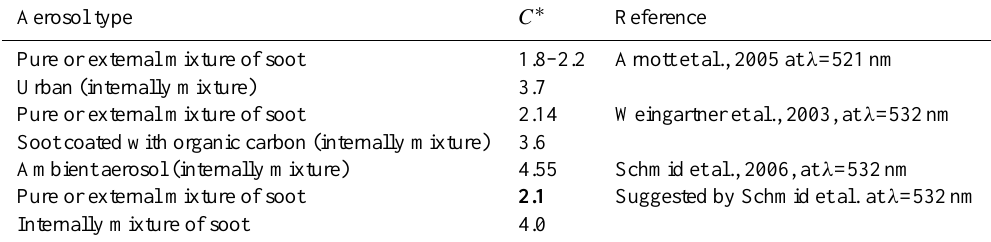
Table 3. Multiple scattering correction factor ( C ∗ ) of different mixing states of EC in previous calibration studies. Aerosol